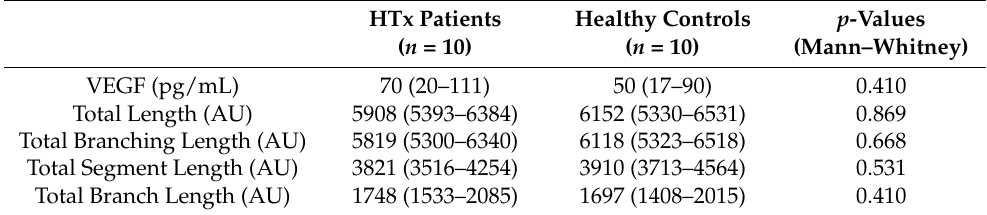
Table 3. VEGF measurement in patient serum and endothelial network